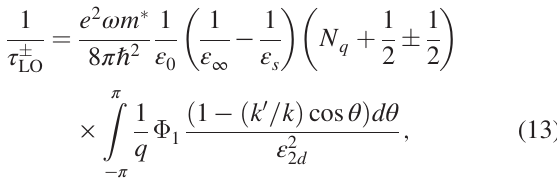
FIG. 3. (a) The normalized polarizability and (b) impurity- limited mobility at different electron densities as a function of temperature.